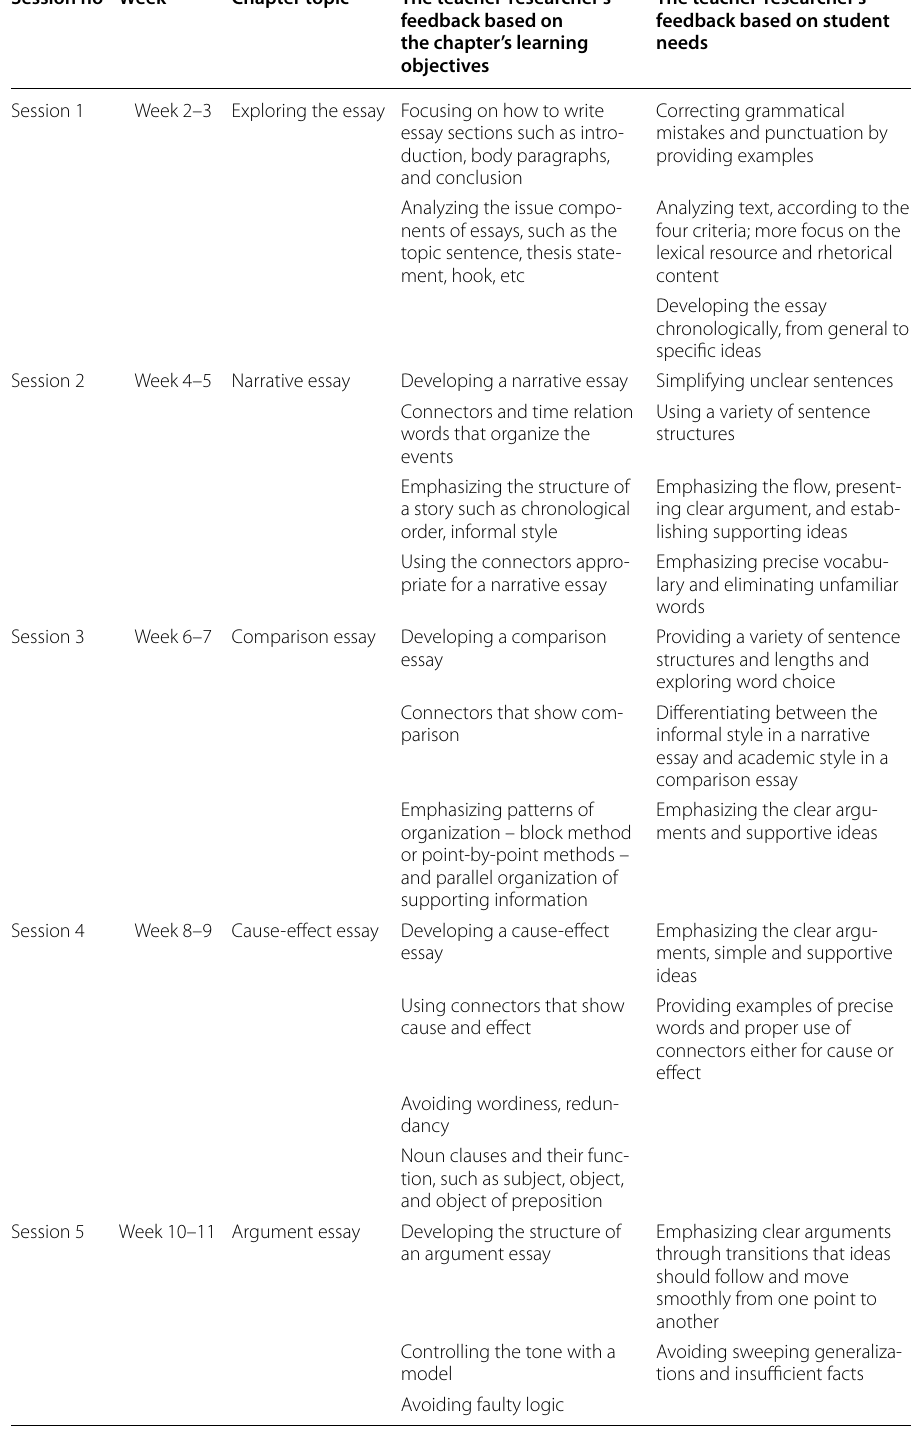
Table 1 Teacher-researcher’s feedback based on students’ needs and learning objectives/outcomes Session no